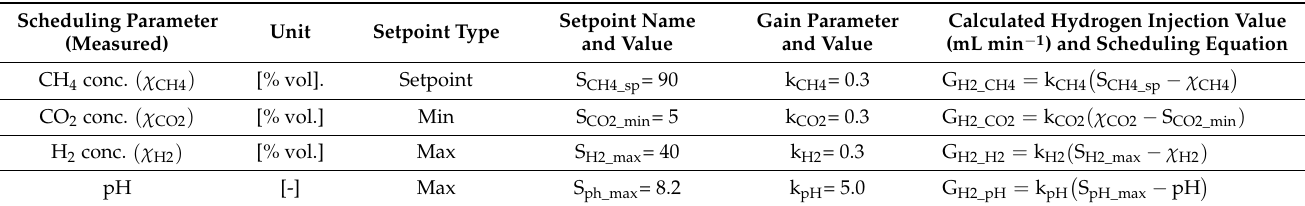
Table 1. Gain scheduling parameters and equations.